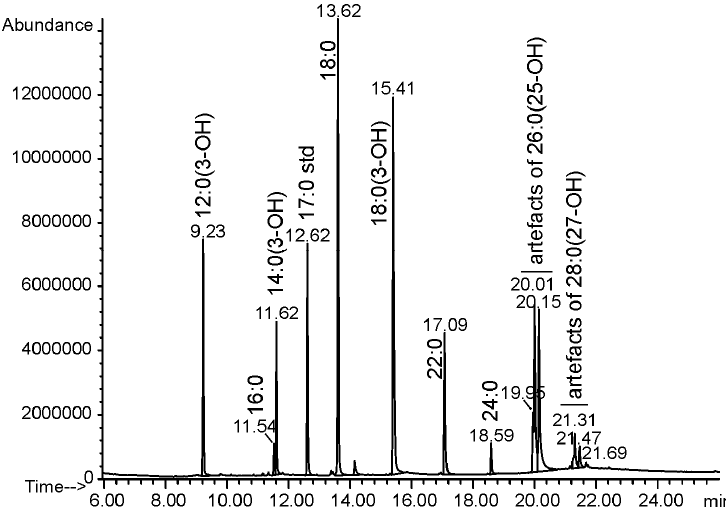
Figure 1. Fatty acid composition of O. carboxidovorans OM5 lipid A. Signals around 20 min and 21.30 min represent three isomers of the dehydrated form of 26:0(25-OH) and 28:0(27-OH), respectively, derived during strong acid hydrolysis (4M HCl aq., 100 °C, 4 h). For conditions of gas chromatography, see Materials and Methods section. Artefacts mean hydrolytically dehydrated hydroxy fatty acids. Std—internal standard. Table 1. Fatty acid components of O. carboxidovorans OM5 lipid A. Component